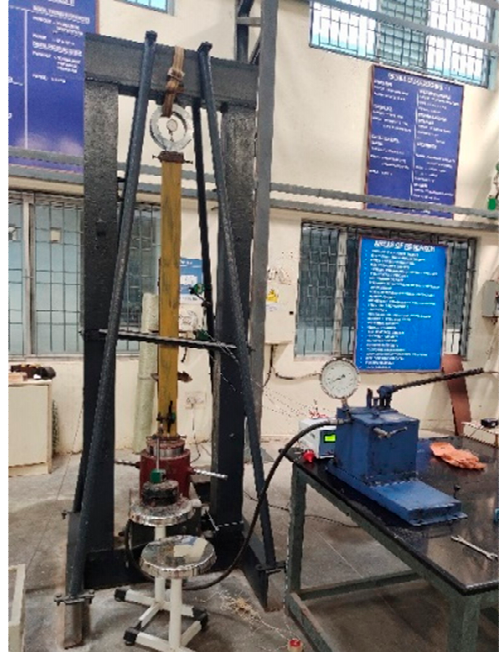
Figure 4. Experimental setup of testing on columns.